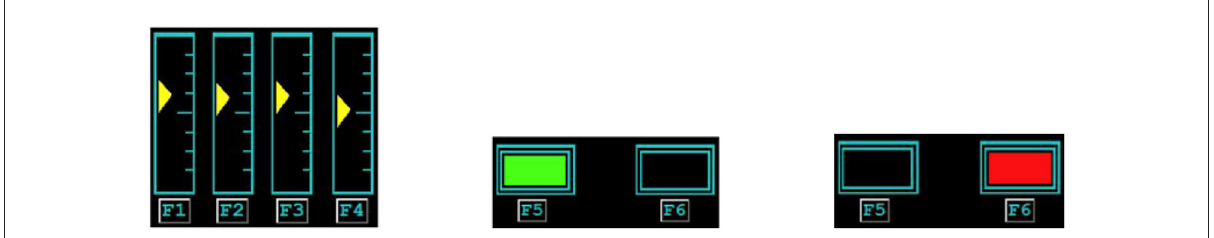
FIGURE1 Left : The Gauges used in the Monitoring (M) subtask of AF-MATB. Middle : The Lights used in the Monitoring (M) subtask of AF-MATB, both properly functioning (Left = Green, Right = Black). Right : The Lights used in the Monitoring (M) subtask of AF-MATB, both signaling a malfunction (Left = Black, Right = Red).